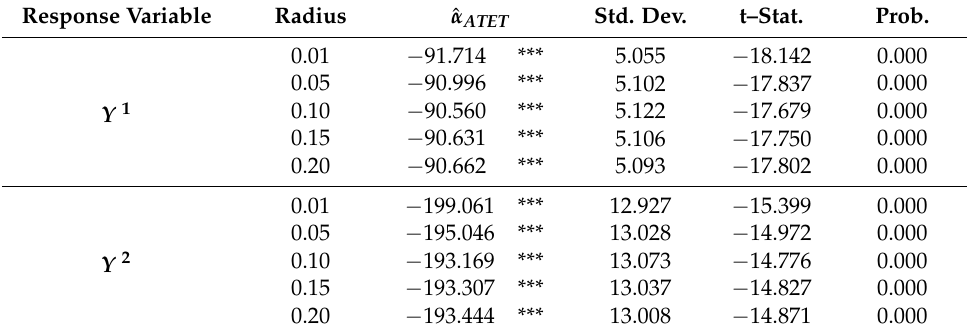
Table 6. ATET estimation—Radial